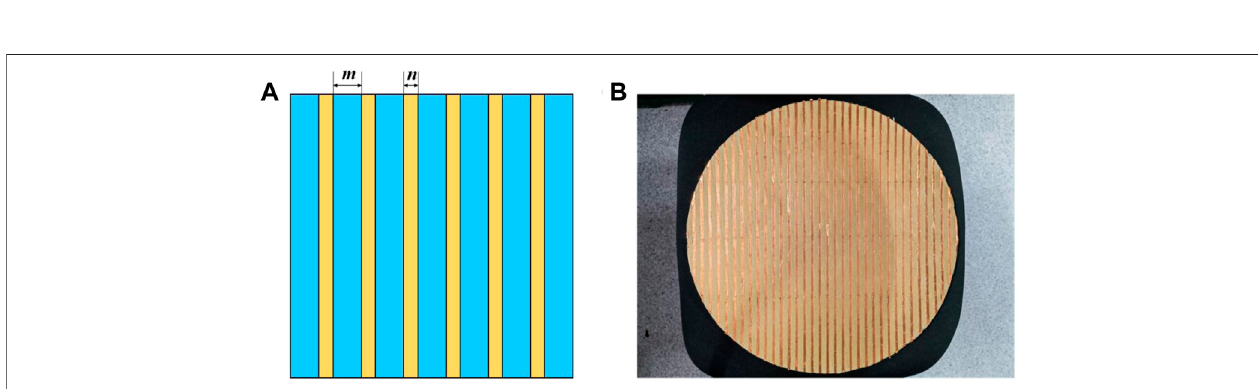
FIGURE 7 | (A) The anisotropic grating unit works at about 9.4 GHz. (B) The real picture of the anisotropic grating.